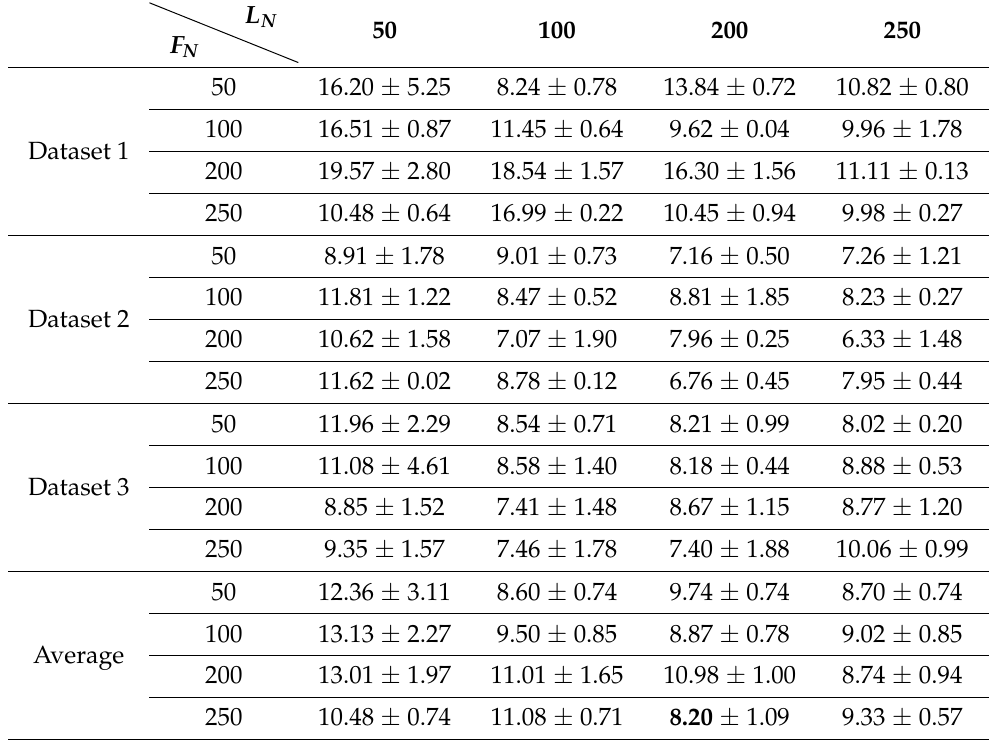
Table 3. Obtained mean and standard deviation of RMSEs with different LSTM unit numbers ( L N ) and convolutional filter numbers ( F N ) for three